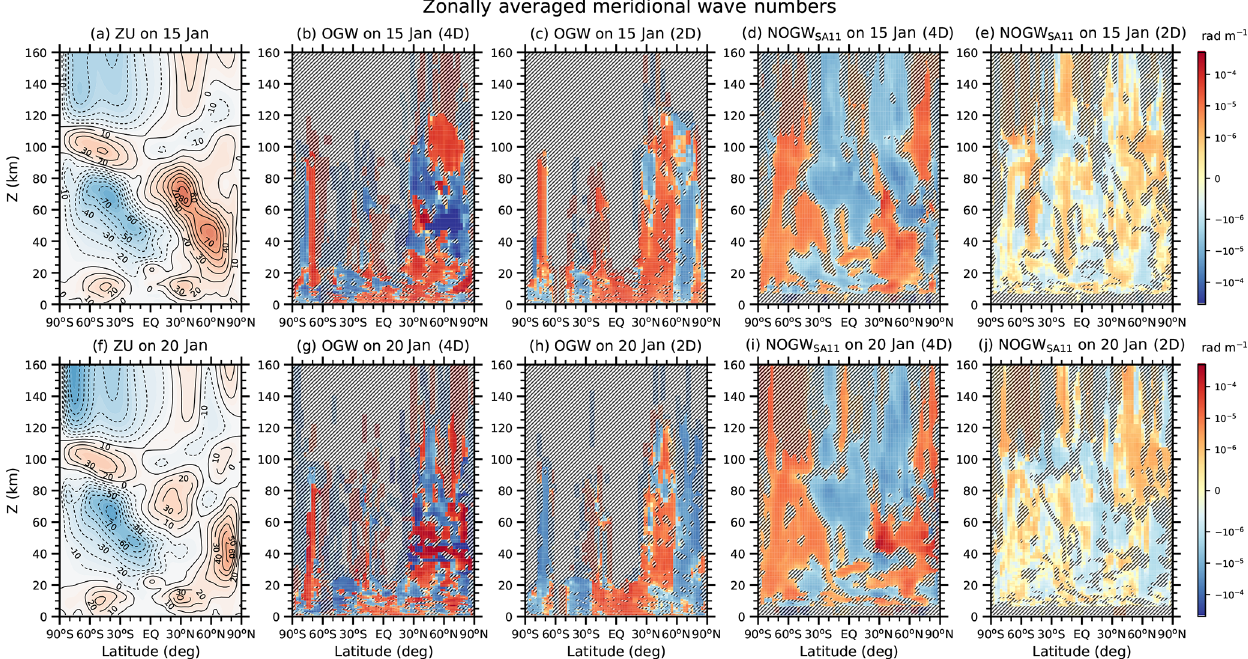
Figure 7. Latitude–height cross sections of zonal mean zonal wind (ZU) and ensemble means of zonally averaged meridional wave numbers ( l ) for OGW and NOGW SA11 in the 4D and 2D experiments at 00:00UTC on (top row) 15 and (bottom row) 20 January 2009. Contour interval for zonal mean zonal wind is 10ms − 1 , and negative values are plotted in broken lines. Hatched areas on the meridional wave numbers indicate regions where the paired and two-tailed t test for the 4D and 2D experiments gives p values larger than 0.05 (i.e., no statistical significance at the level of 0.05).